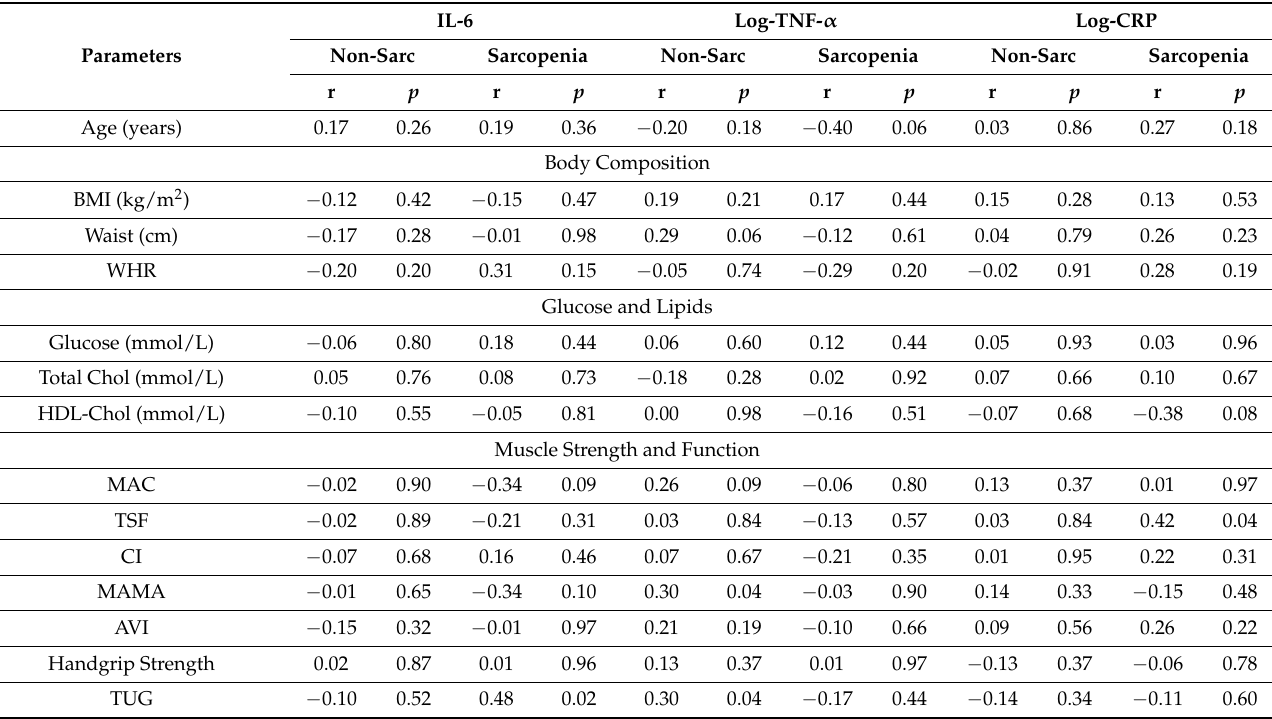
Table 5. Correlation analysis for IL-6, TNF- α , and CRP with other